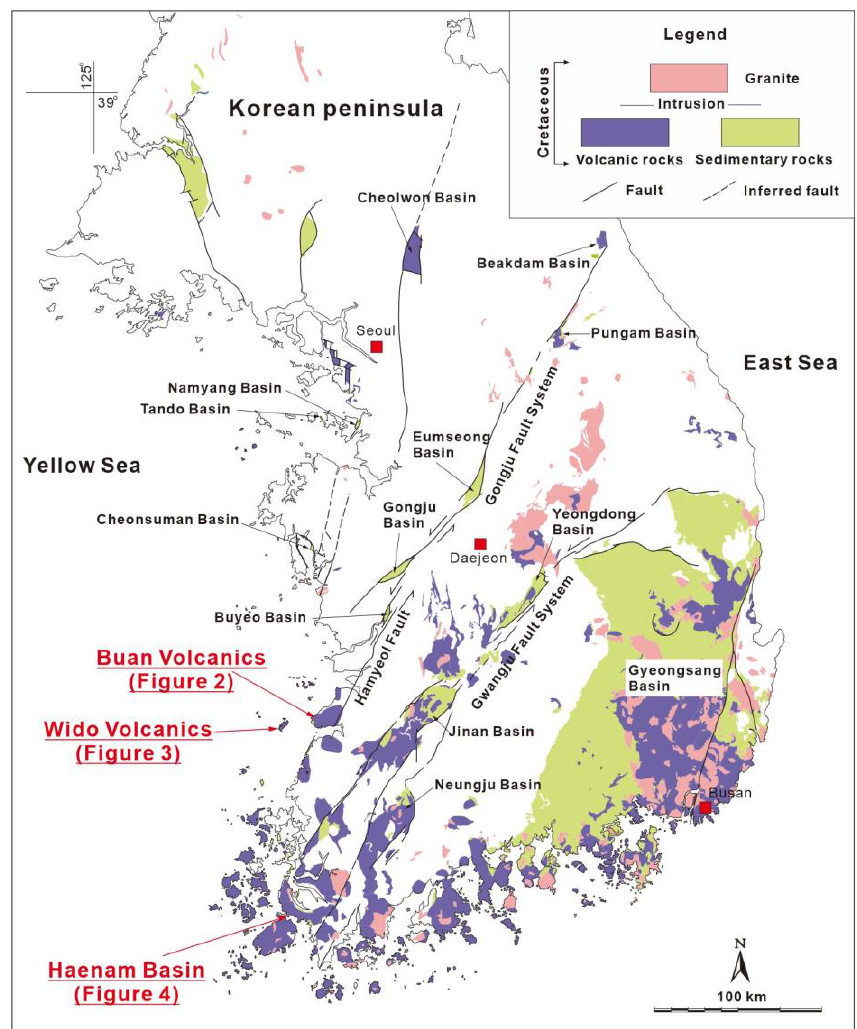
Figure 1. Map of the southern Korean Peninsula showing the distribution of Cretaceous sedimentary basins, and volcanic and igneous rocks along sinistral strike–slip fault systems (modified from [12]).